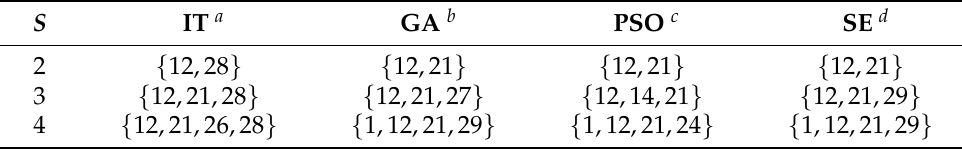
a Algorithm 1. b Genetic algorithm, reported in [28]. c Particle swarm optimization, reported in [28]. d Semi- exhaustive search, reported in [28].